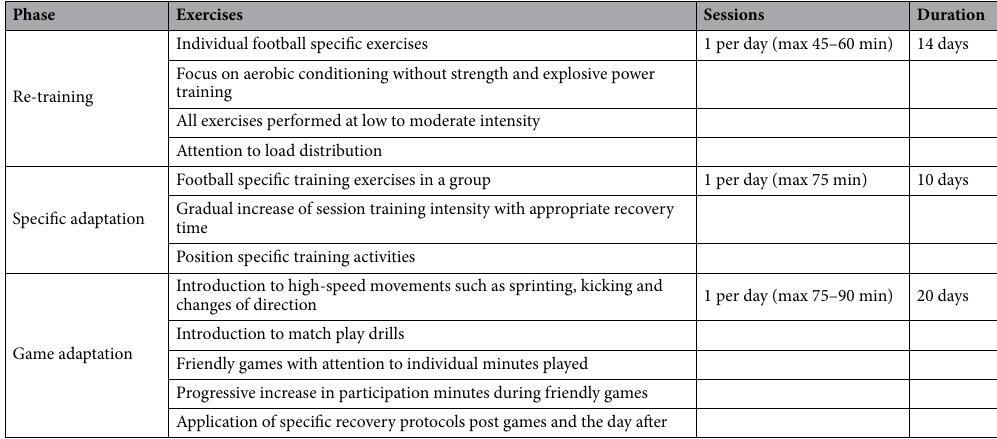
Table 2. Phases: return to training and games following COVID-19